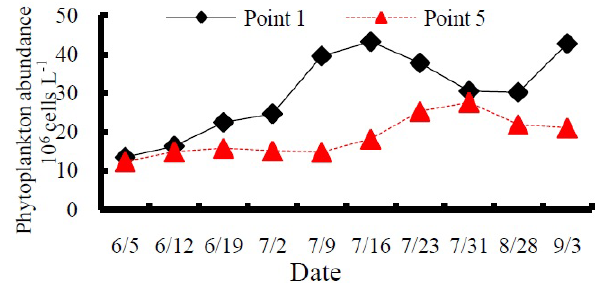
Figure 8. Changes in the phytoplankton abundance in the two sites during the test period.